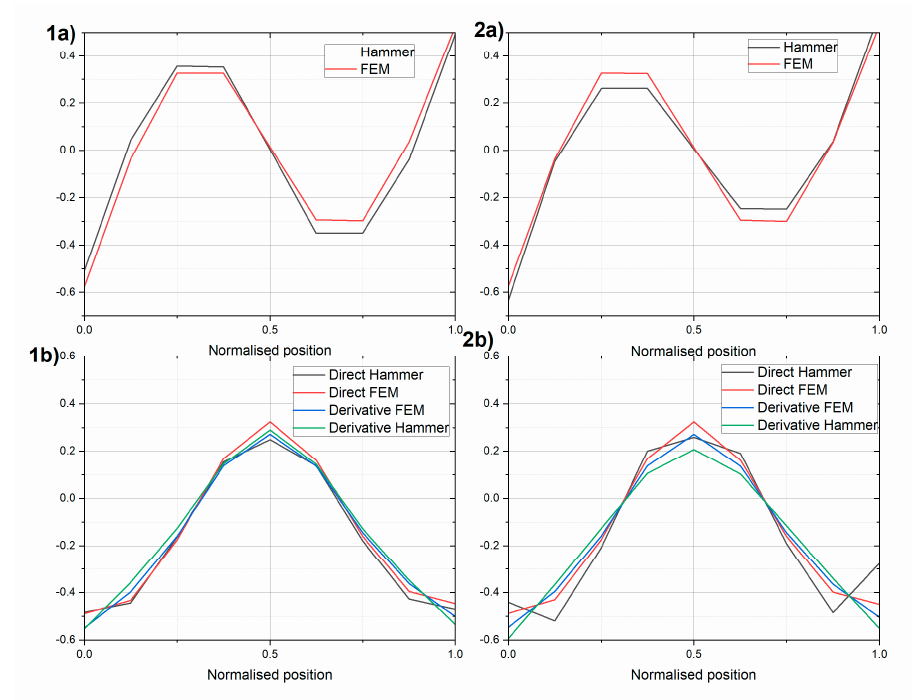
Figure 9. Comparison of the second ( a ) translational and ( b ) rotational modes of (1) beam UHPC1_L and (2) beam UHPC2_L. Results for the intact beams.